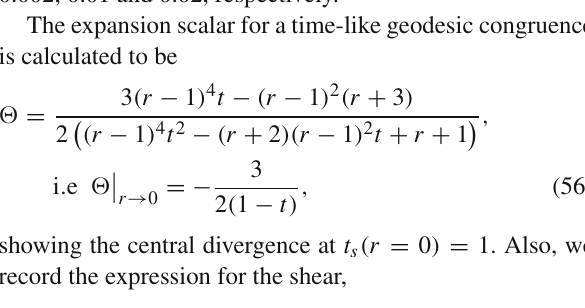
Fig. 14 Conditions (i), (ii), (iv) at t = 0 . 5